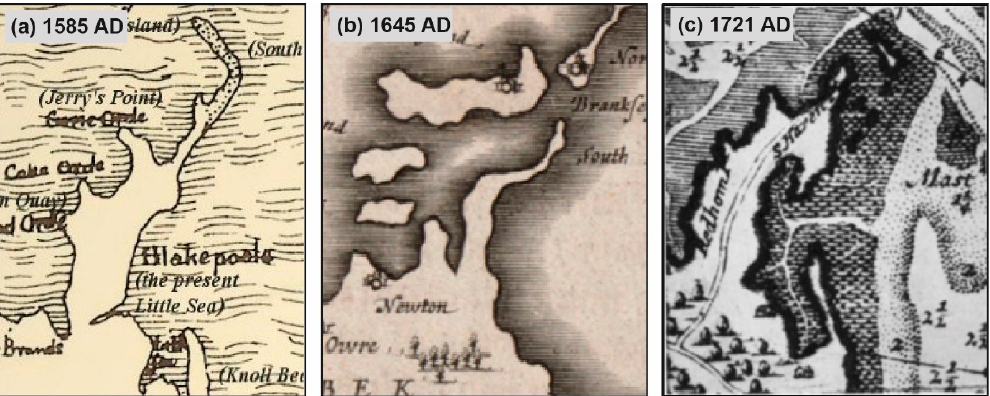
Figure 2. Physiological maps of the South Haven Peninsula during ( a ) the late 16th century AD [17]; ( b ) the mid-17th century AD [20,22]; ( c ) and the early 18th century AD [6,23].